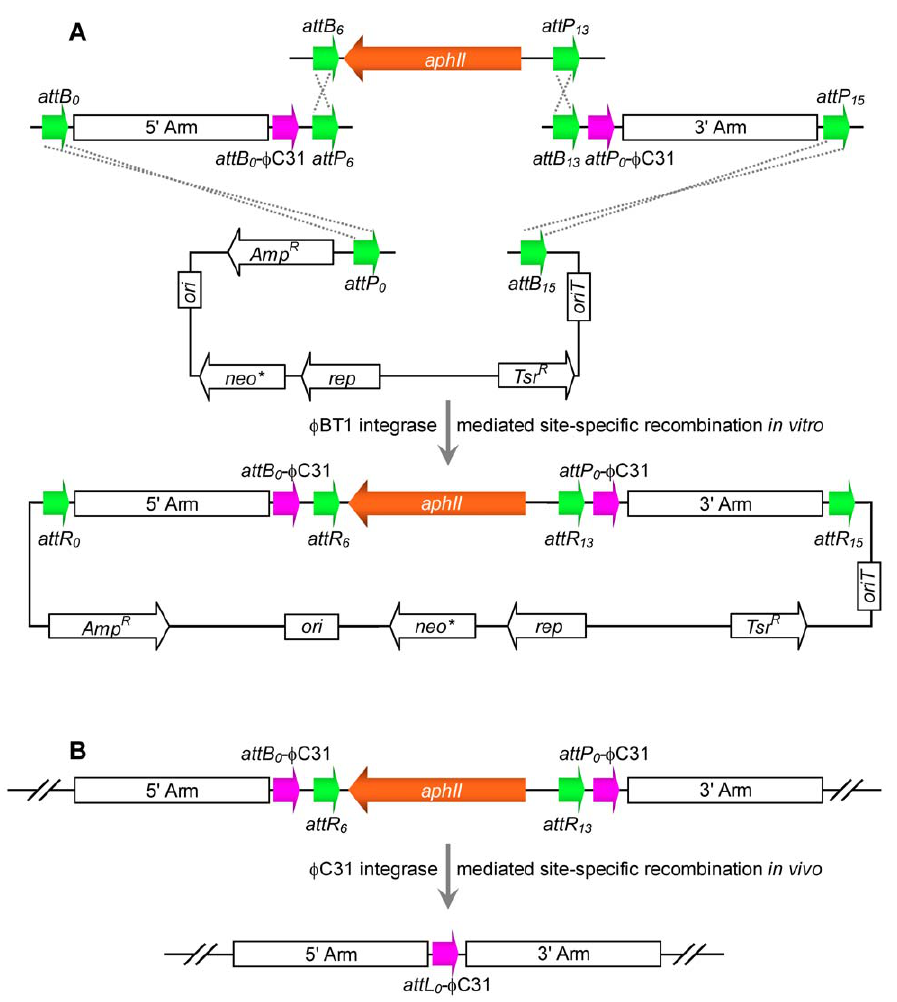
Figure 2. Strategy of tandem assembly invitro and the marker removing invivo based on site-specific recombinations. (A) One step assembly of the gene-targeting vector by w BT1 integrase-mediated site-specific recombination in vitro . Four recombination reactions occurred simultaneously between attB 0 /attP 0 , attB 6/ attP 6 , attB 13 /attP 13 , and attB 15 /attP 15 . (B) Deletion of marker by w C31 integrase-mediated site-specific recombination in vivo . The reaction occurred between attB 0 - w C31 and attP 0 - w C31 to remove the marker and leave attL 0 - w